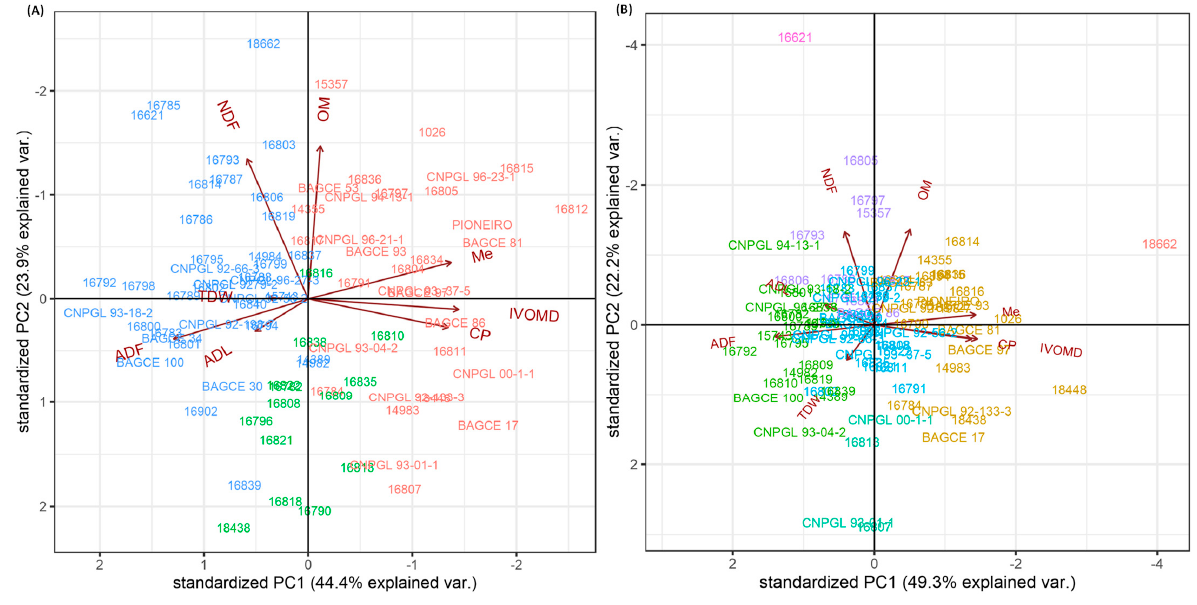
Figure A2. PCA biplots of feed quality traits and total dry weight (TDW) of Napier grass genotypes growing under: ( A ) moderate water stress conditions and ( B ) severe water stress conditions. The color of genotypes indicates different cluster groups using pattern analysis. The angles between vectors indicate the degree of correlation between traits. Neutral detergent fiber (NDF); acid detergent fiber (ADF); acid detergent lignin (ADL); organic matter (OM); crude protein (CP); in vitro organic matter digestibility (IVOMD); metabolizable energy (ME).